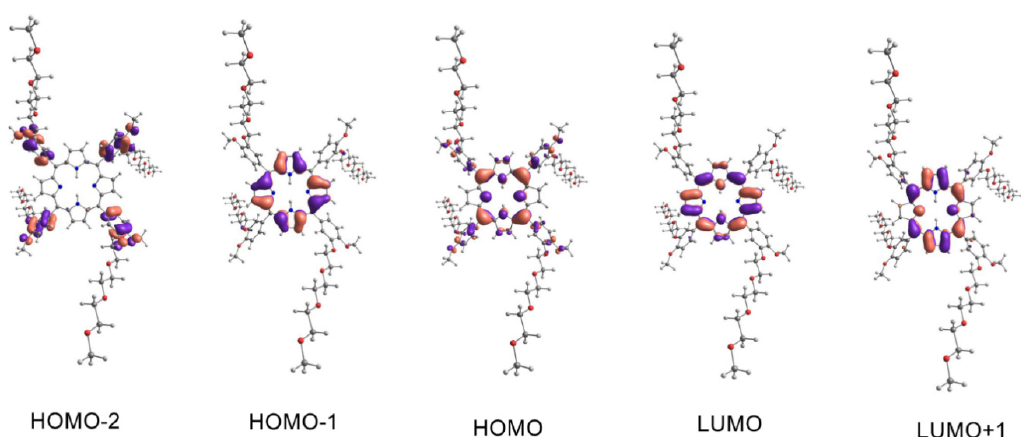
Figure 5. The molecular orbitals involved as the main component in the electronic transitions of 3 . Spatial functions representing orbitals were computed by application of PCM/TD-DFT/PBE1PBE/6- 31+G(d,p)//PBE1PBE/6-31G(d,p) with a contour value 0.03 a.u. The isosurfaces marked by the violet and salmon colors represent parts of the orbitals in different phases.